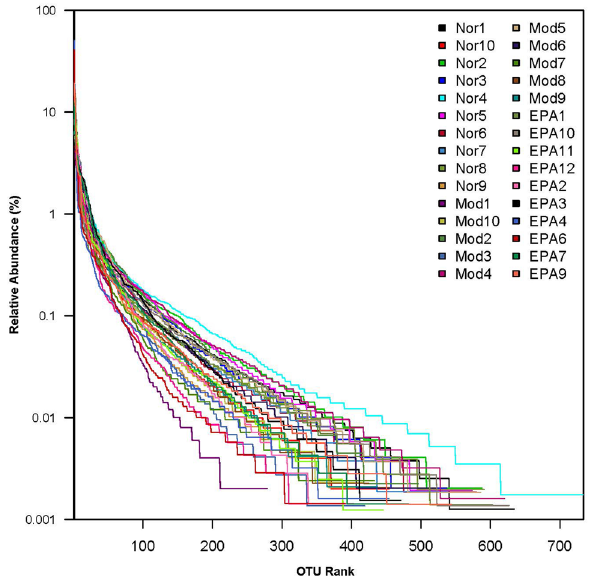
Figure 7. OTU Rank-Abundance curves. Different samples are represented by curves of different colors. The abscissa is the number rank sorted by OTU abundance, and the ordinate is the corresponding OTU abundance.